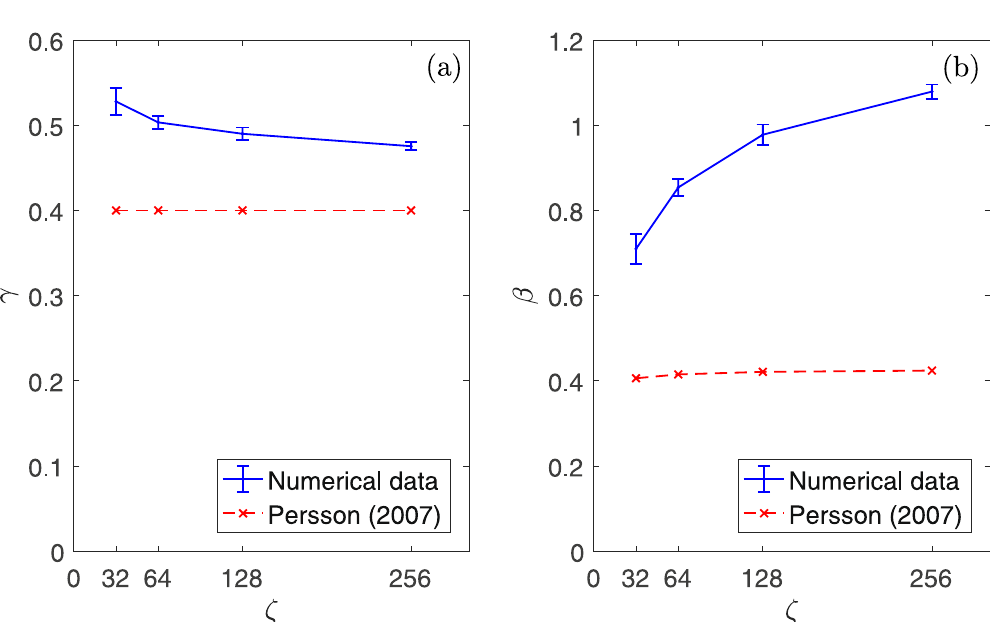
Figure 5. γ = . . . . [0 53, 0 50, 0 49, 0 48] and β = . . . . [0 71, 0 85, 0 98, 1 08] (respectively ( a ),( b )), for α = 1, obtained from the fitting of eq. (2) for increasing magnification ζ = [32, 64, 128, 256] and compared with Persson prediction 13 .